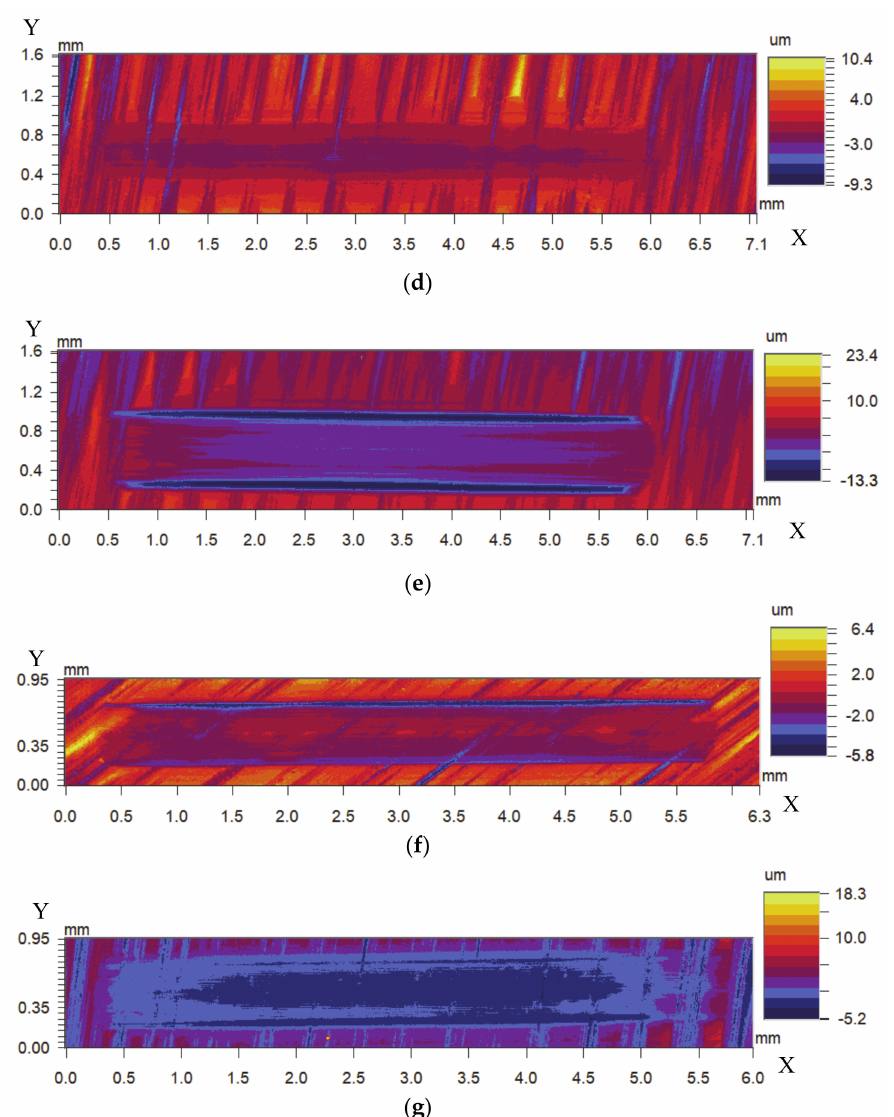
Figure 13. Three-dimensional white-light interference images of wear traces morphology of plasma-nitrided specimens tested at: ( a ) 50 N / 83.3 mm · s − 1 / 298 K, ( b ) 100 N / 83.3 mm · s − 1 / 298 K, ( c ) 150 N / 83.3 mm · s − 1 / 298 K, ( d ) 100 N / 16.7 mm · s − 1 / 298 K, ( e ) 100 N / 50 mm · s − 1 / 298 K,